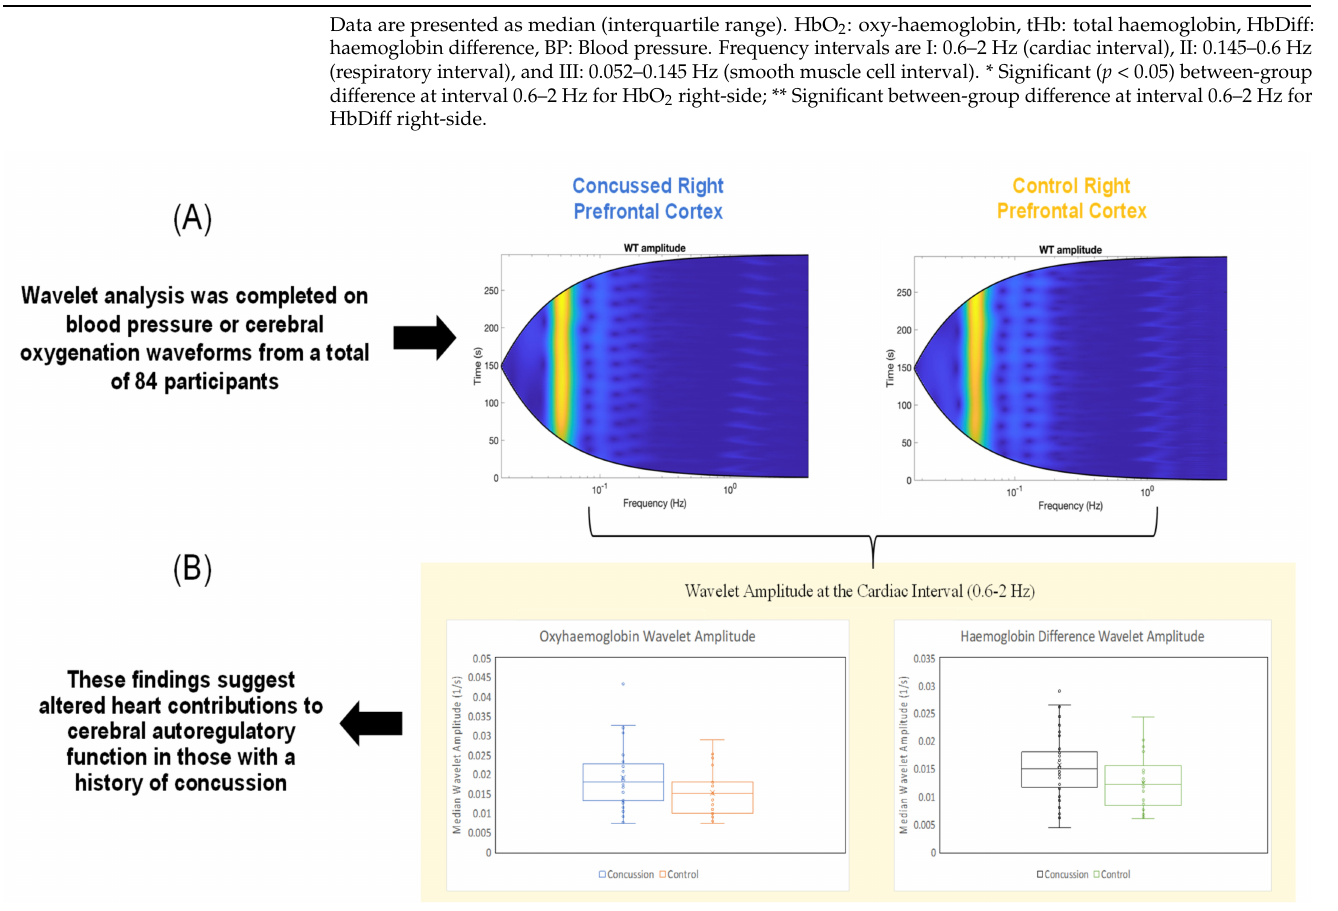
distribution (Hz) and amplitude changes in relation to time (seconds, s) for the right prefrontal cortex oxygenation for the concussed (SRC) and control (CTR) groups. Panel ( B ) shows the box − plots for the calculated values found in Table 1. The box − plots shown here represent the cardiac